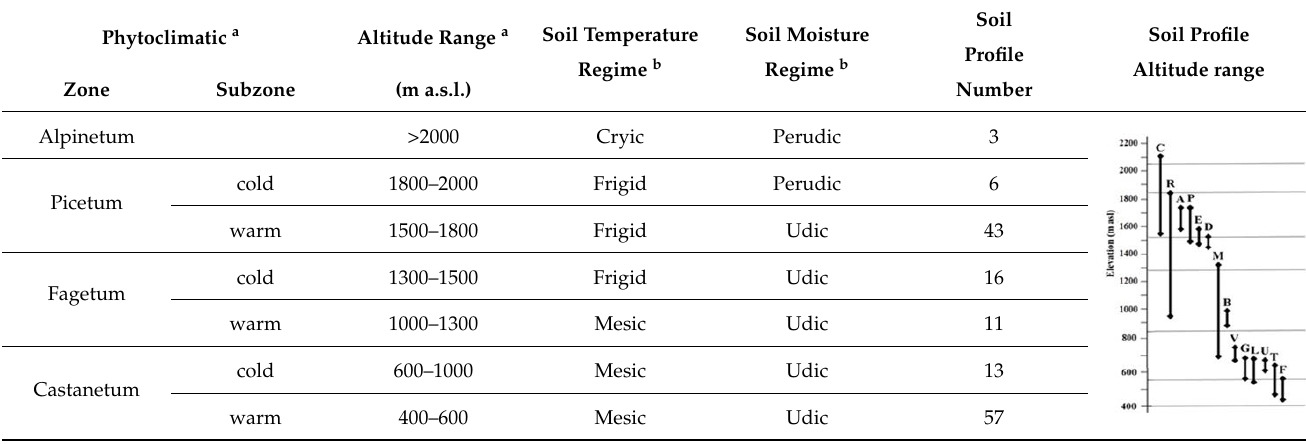
Table 1. Altitudinal range, soil temperature regime, and soil moisture regime of the phytoclimatic zones and subzones of the northern Apennine chain, Italy, according to De Philippis [73,74] and Soil Survey Staff [52] and the location of soil profiles within the altitudinal ranges. The capital letters refer to soil sampling areas, as shown in Figure 1.